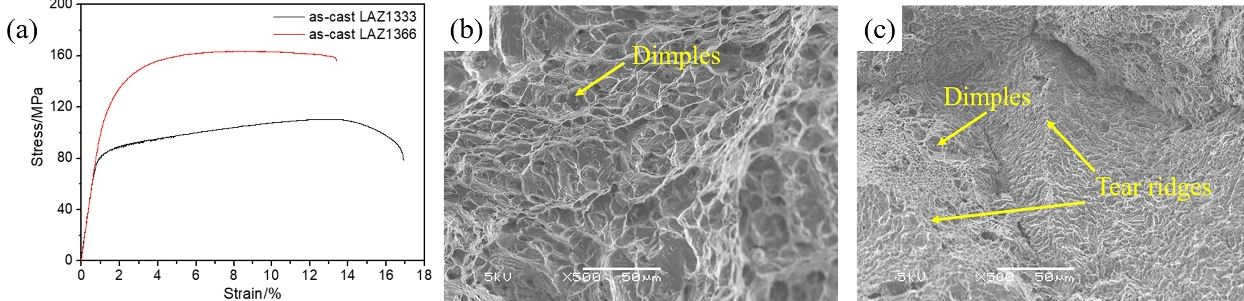
Figure 10. Room temperature tensile stress–strain curves and fracture morphology of the as-cast LAZ13 xy ( x = 3, 6 wt%, y = 3, 6 wt%) alloys: ( a ) tensile stress–strain curves, fracture morphology of as-cast ( b ) LAZ1333 and ( c ) LAZ1366.